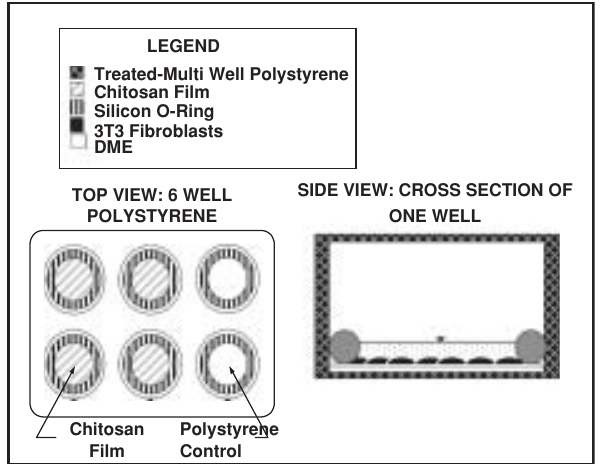
Figure 2 Cell attachment and growth experimental